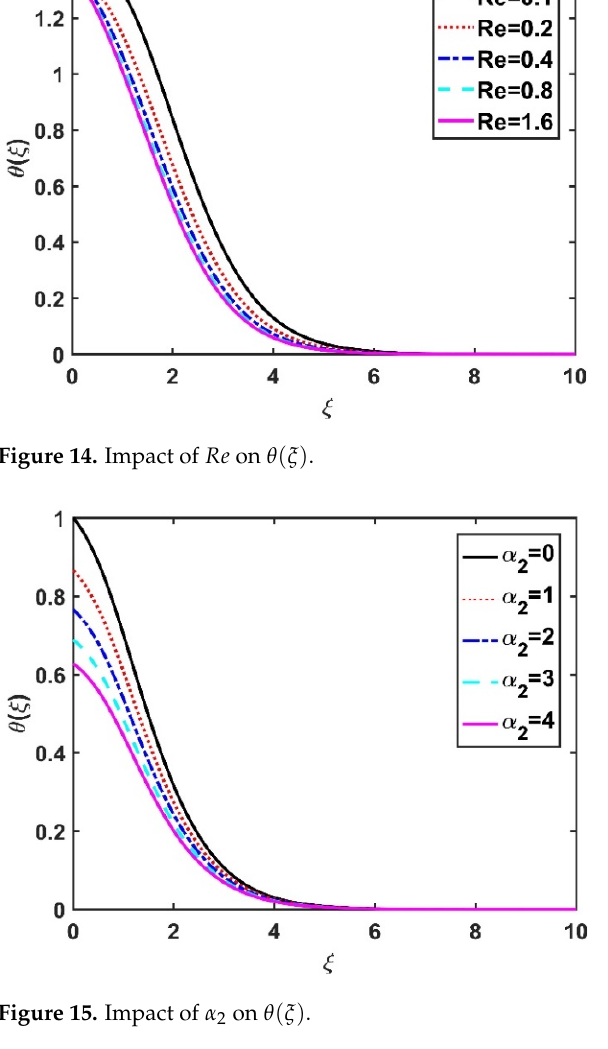
Figure 13. Impact of 𝑁𝑡 on 𝜃(cid:4666)𝜉(cid:4667) .